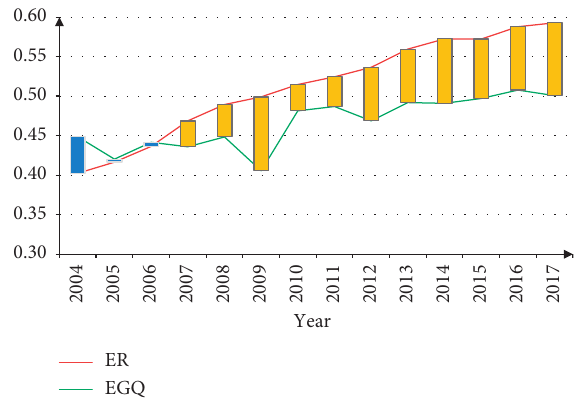
Figure 3: The change trend of ER and EGQ subsystem index from 2004 to 2017.